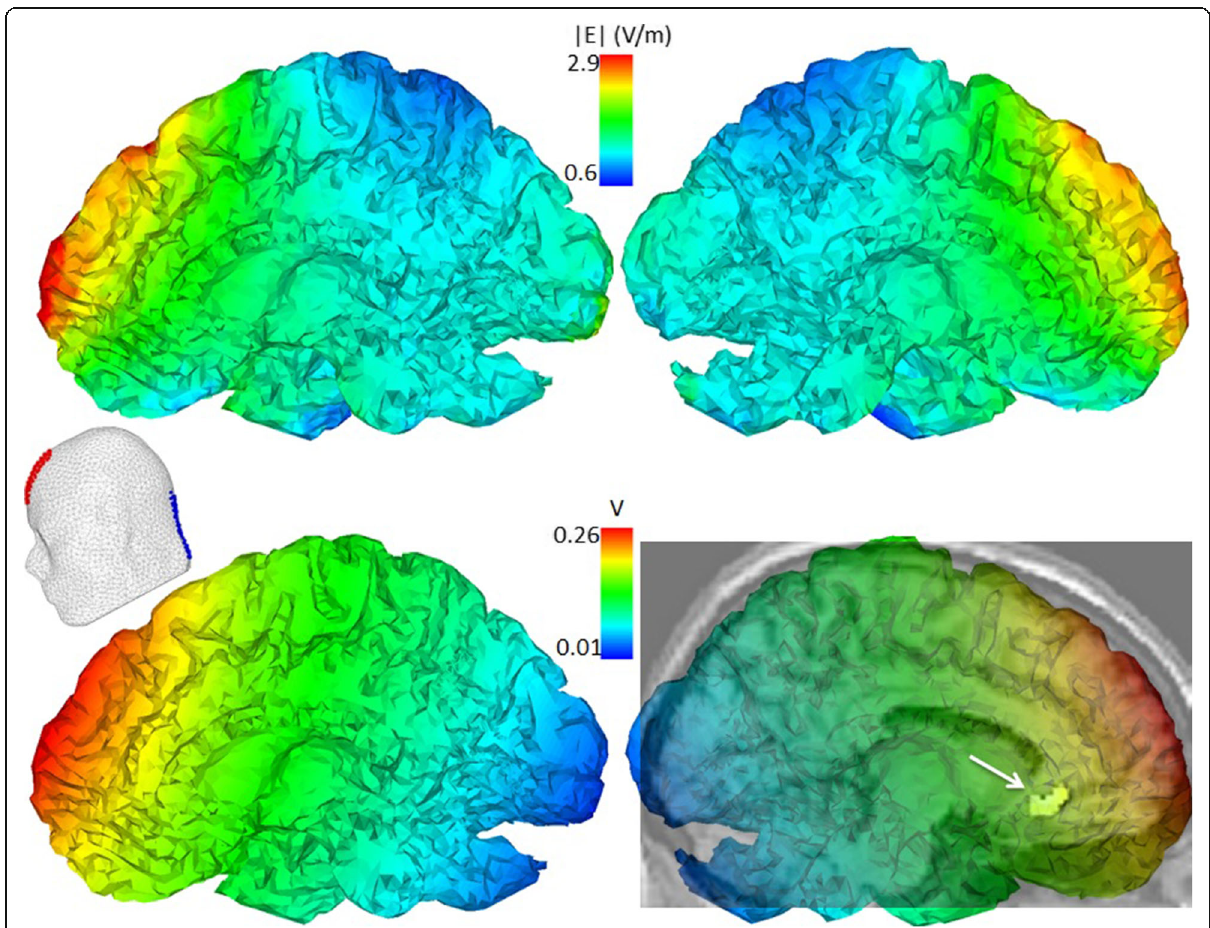
Fig. 2 Brain maps of absolute values of electric field intensity (E = V/m) and electric potential (V) in sagittal planes of right and left cerebral hemispheres simulated using COMETS [34] and taking into account tDCS electrode size and placement (insert on the left) as well as current intensity. Lower right: superimposed left sagittal section of a normalized MRI template displaying the subgenual area of the left anterior cingulate cortex (arrow) with increased glucose uptake on FDG-PET in rCCH patients responding to percutaneous ONS compared to non-responders